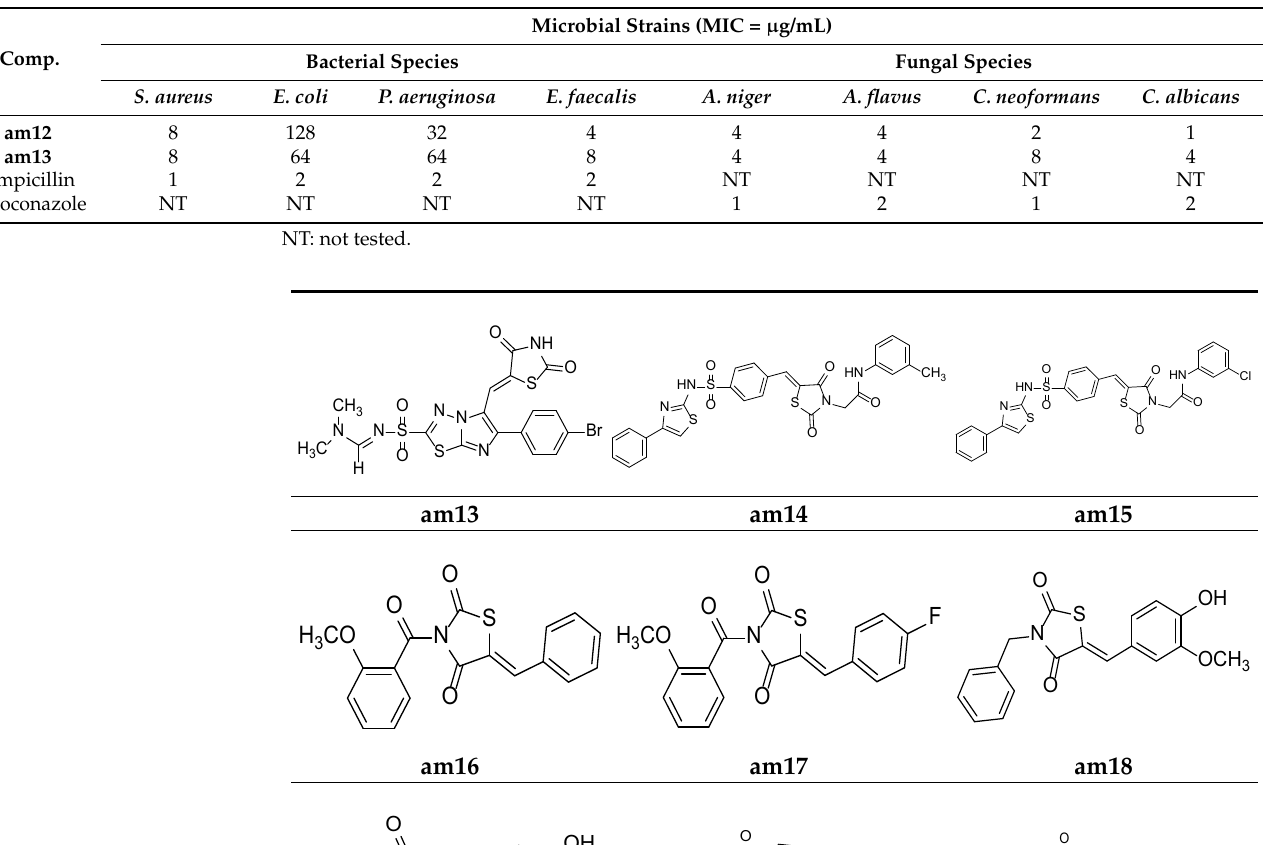
Table 7. Antimicrobial activity (MIC = µ g/mL) of the compounds ( am12 – am13 ).